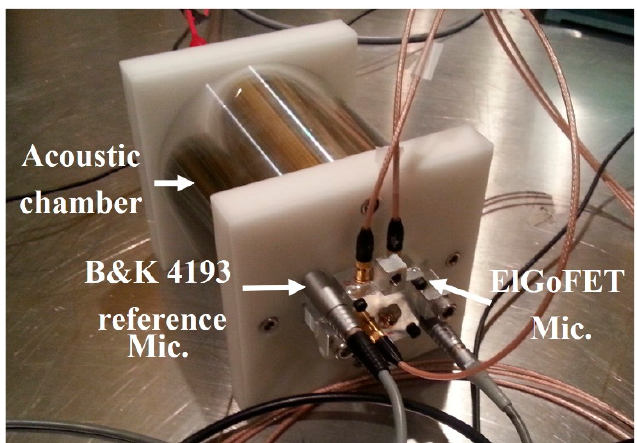
Figure 10. Calibration set-up for the ElGoFET microphone: small chamber for generating low-frequency acoustic calibration.